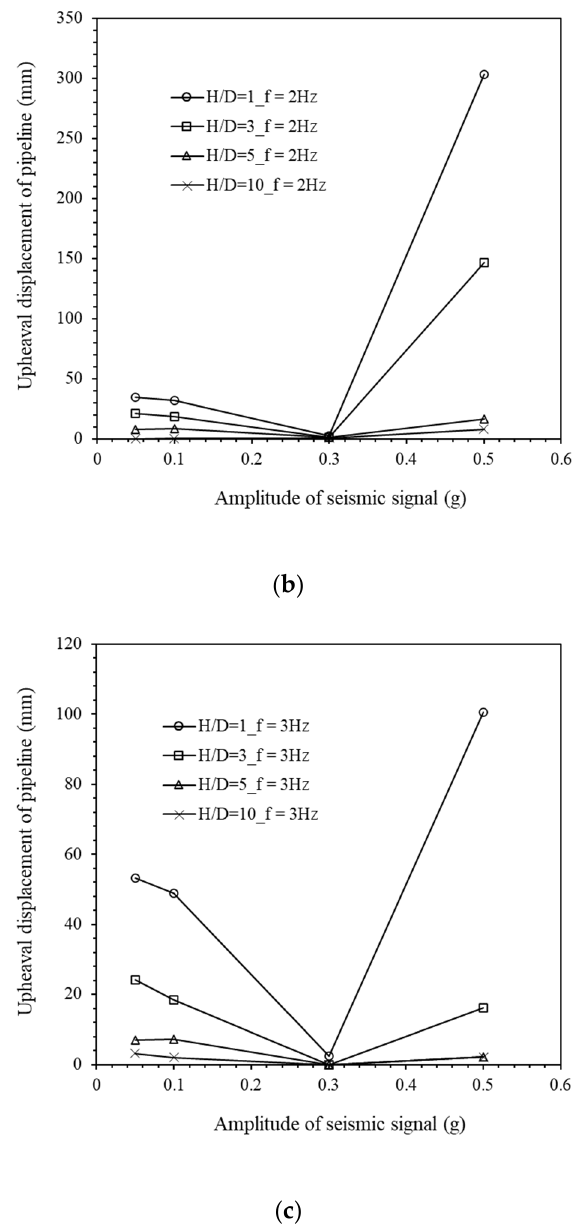
Figure 8. Variation of the pipe upheaval displacement with the amplitude of the seismic signal for frequencies of ( a ) 1 Hz, ( b ) 2 Hz, and ( c ) 3 Hz.